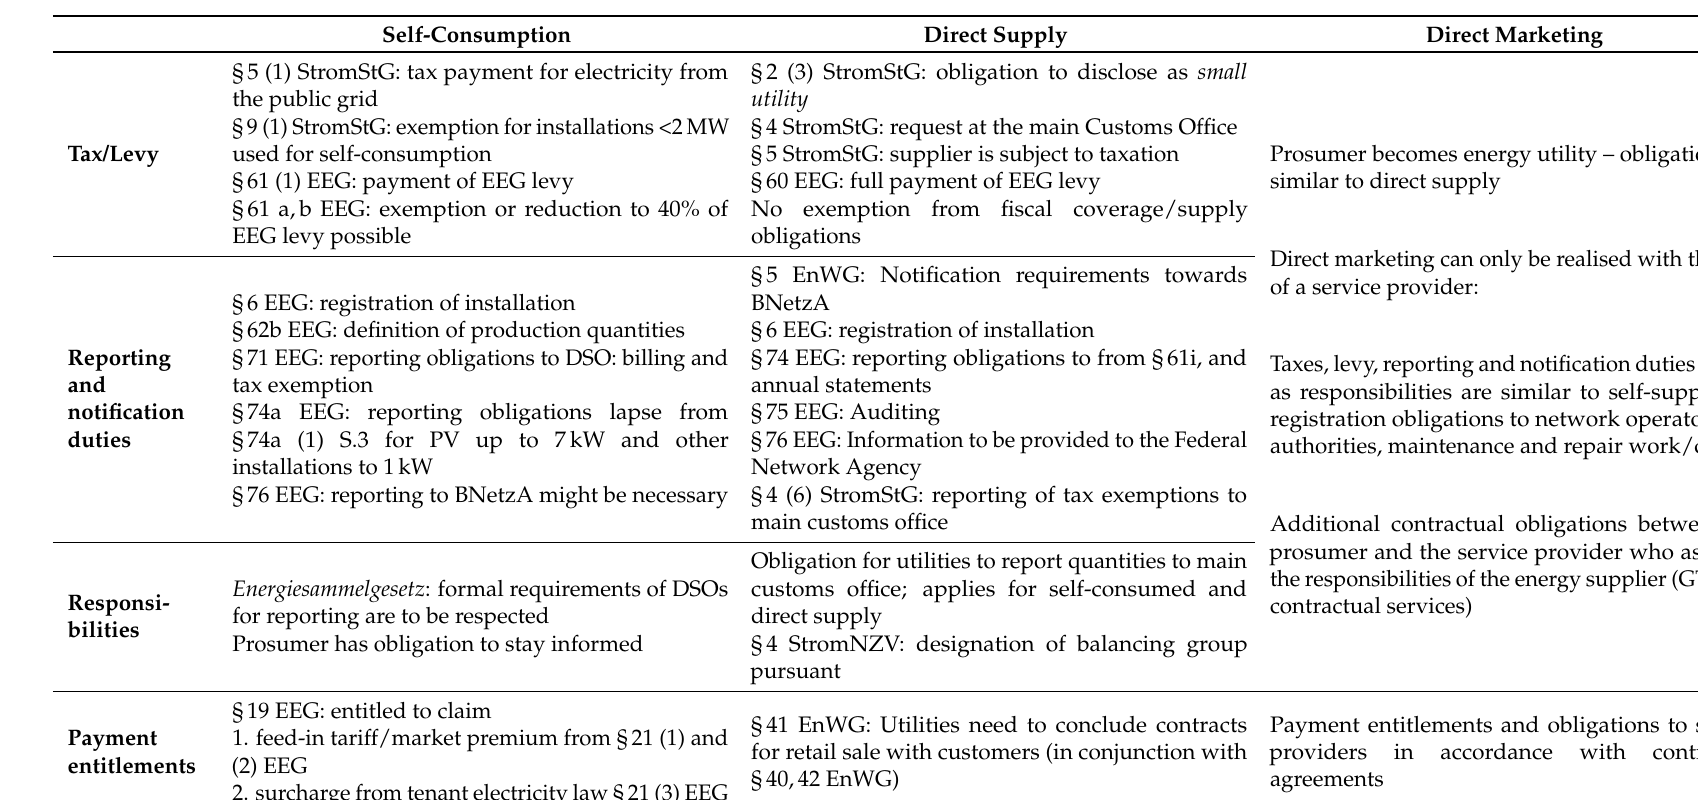
Table A3. Overview on the German regulatory framework for